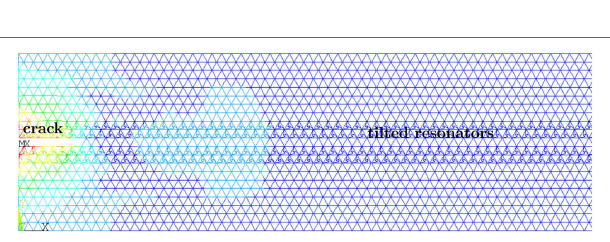
FIGURE 15 | Instantaneous modulus of the displacement for the time step t / θ (cid:25) 10 in the transient simulation represented in Figure 14B for the elongation threshold ϵ = 5 (cid:1) 10 − 3 (red dotted line). The crack tip “emits” elastic waves that propagate along the